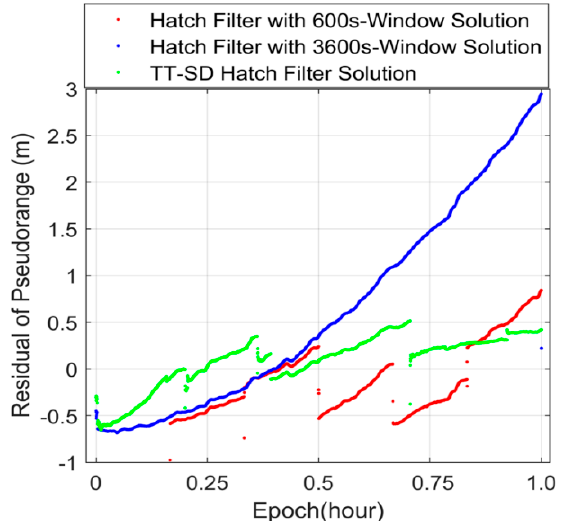
Figure 4. Pseudorange residuals. The green line represents the single-difference smoothed pseudorange residuals between reference satellite G03 and non-reference satellite G29.